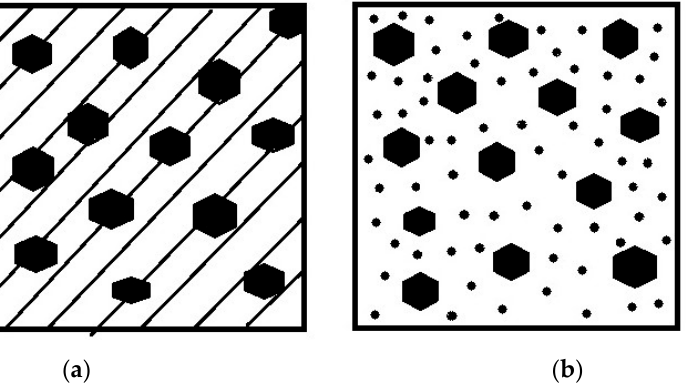
Figure 1. Schematic representation of the target NMMC microstructure: ( a ) as-cast condition; ( b ) after spheroidising annealing.